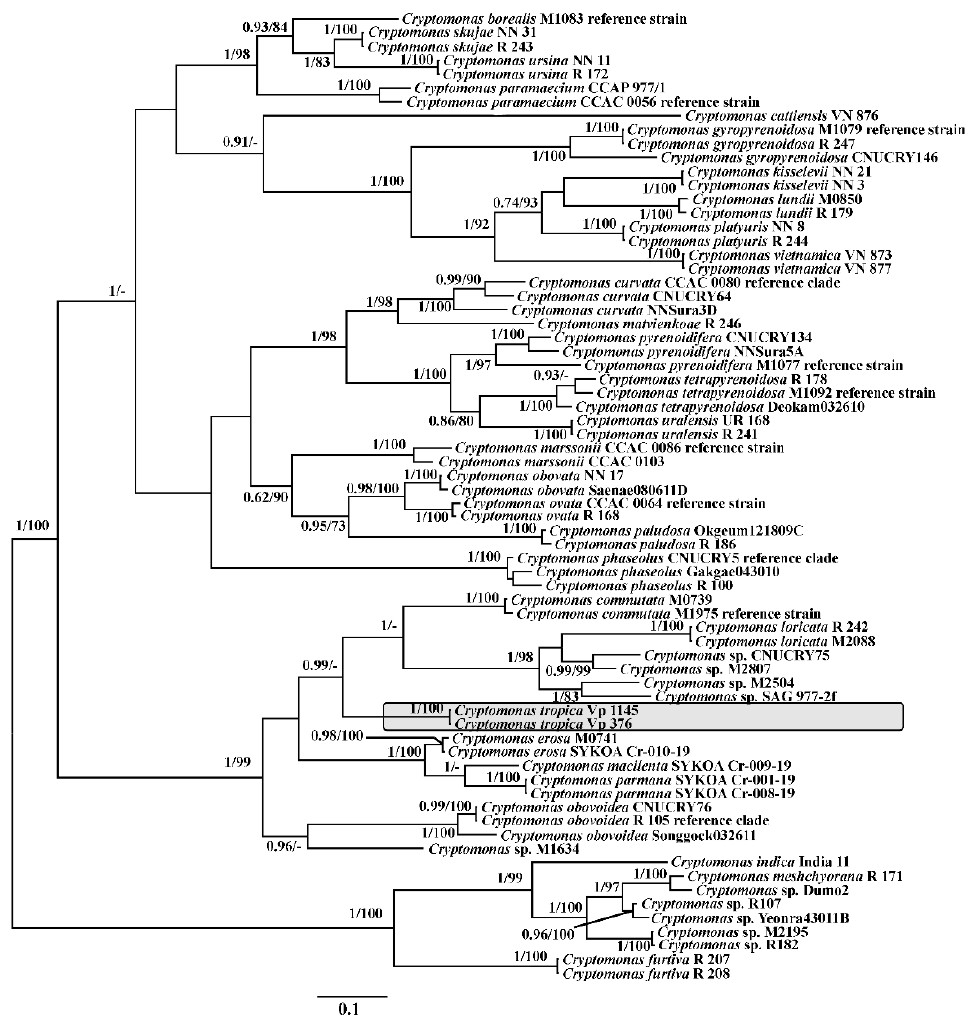
Figure 5. Molecular phylogeny of the genus Cryptomonas , based on the nuclear internal transcribed spacer 2 (ITS2 rDNA) sequences. Bayesian Posterior Probabilities and Maximum Likelihood bootstrap support shown left and right of the fraction line, respectively. Scale bar represents substitutions per site. New described species are marked within the grey box.